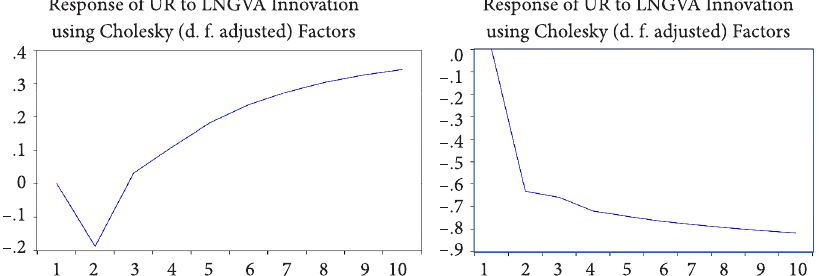
Figure 2. The impulse-response function when KSI and EMI are endogenous (left) and when KSI and EMI are exogenous